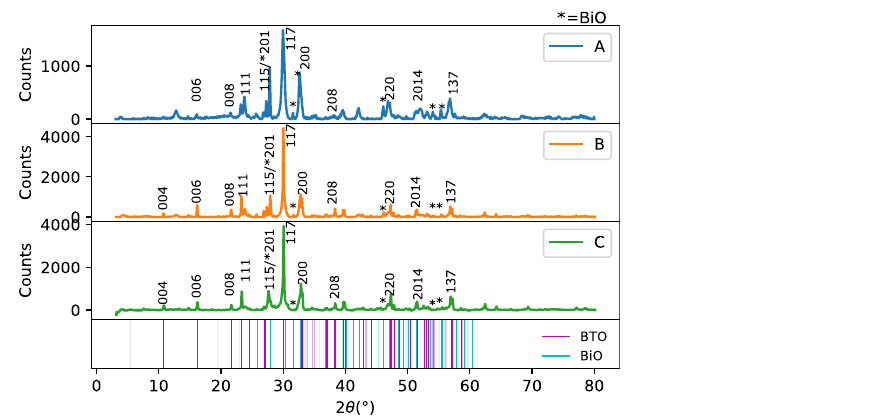
Figure 1 X-ray diffraction pattern of BTO samples (A), (B) and (C) prepared by varying PEG-6000 added during synthesis with matching lines for Bi 4 Ti 3 O 12 JCPDS 35-0795 and minute traces of Bi 2 O 3 JCPDS 77-0374. The bottom subplots show the prominent peaks of JCPDS fi les 35-0795 (BTO) and 77-0374 (BiO), where the thickness of the line corresponds to the prominence of the peak. The Bi 2 O 3 peaks are marked with an asterisk ( (cid:3) ) instead of indices.